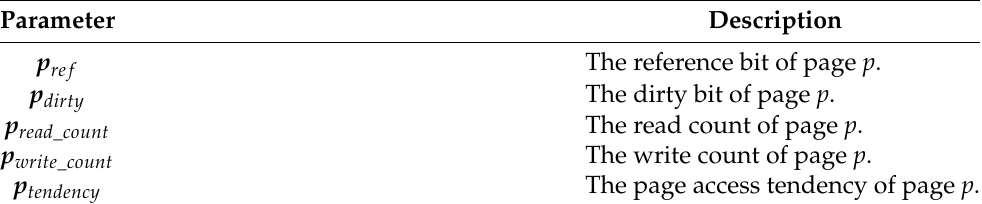
Table 4. Definition of parameters in Algorithms 1 and 2.